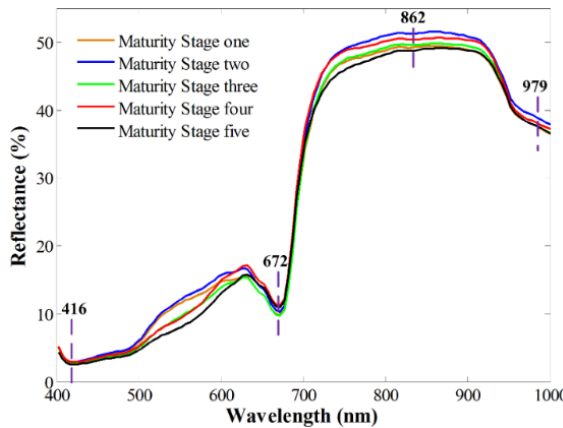
Figure 4. Average spectra of Camellia oleifera fruits at each maturity